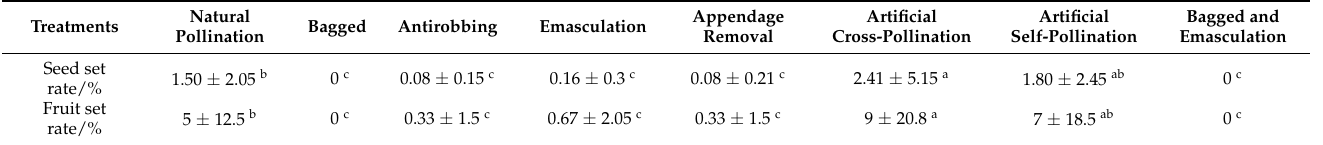
Different superscript letters within the same row indicate significant difference at p < 0. 05.